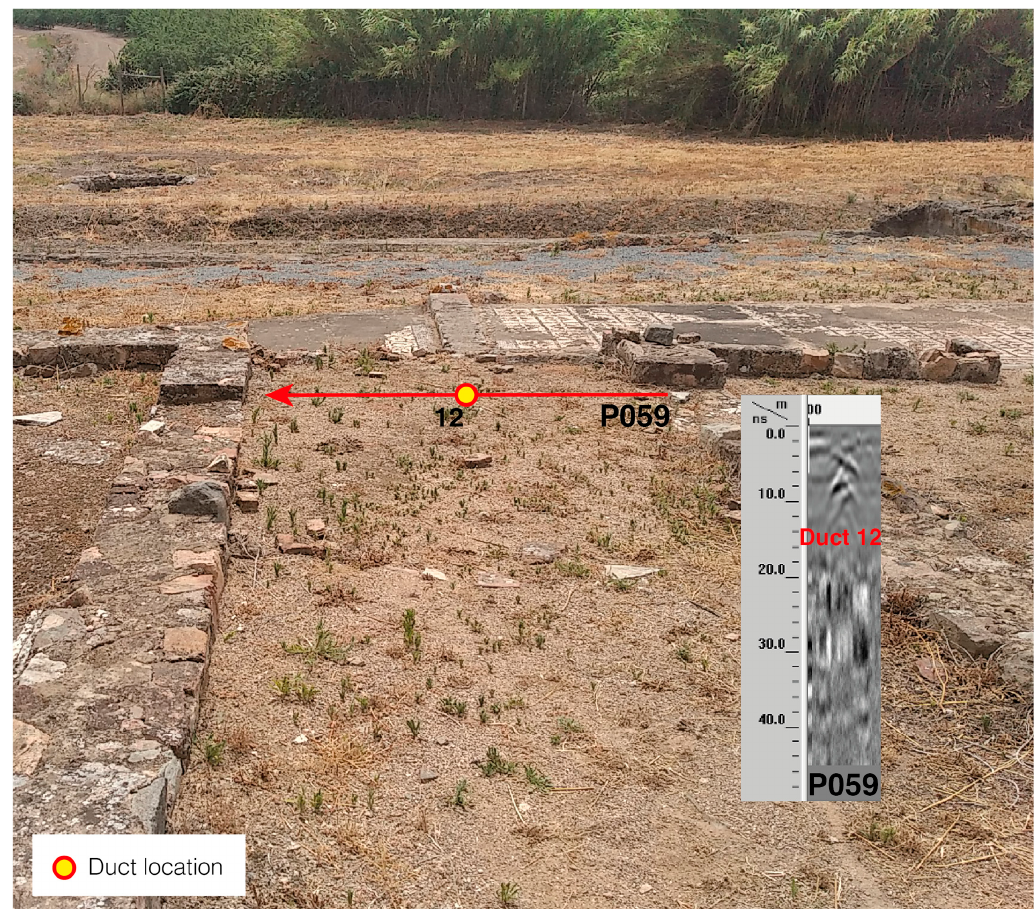
Figure 10. Representation of B-scan P059 and its location in the field.